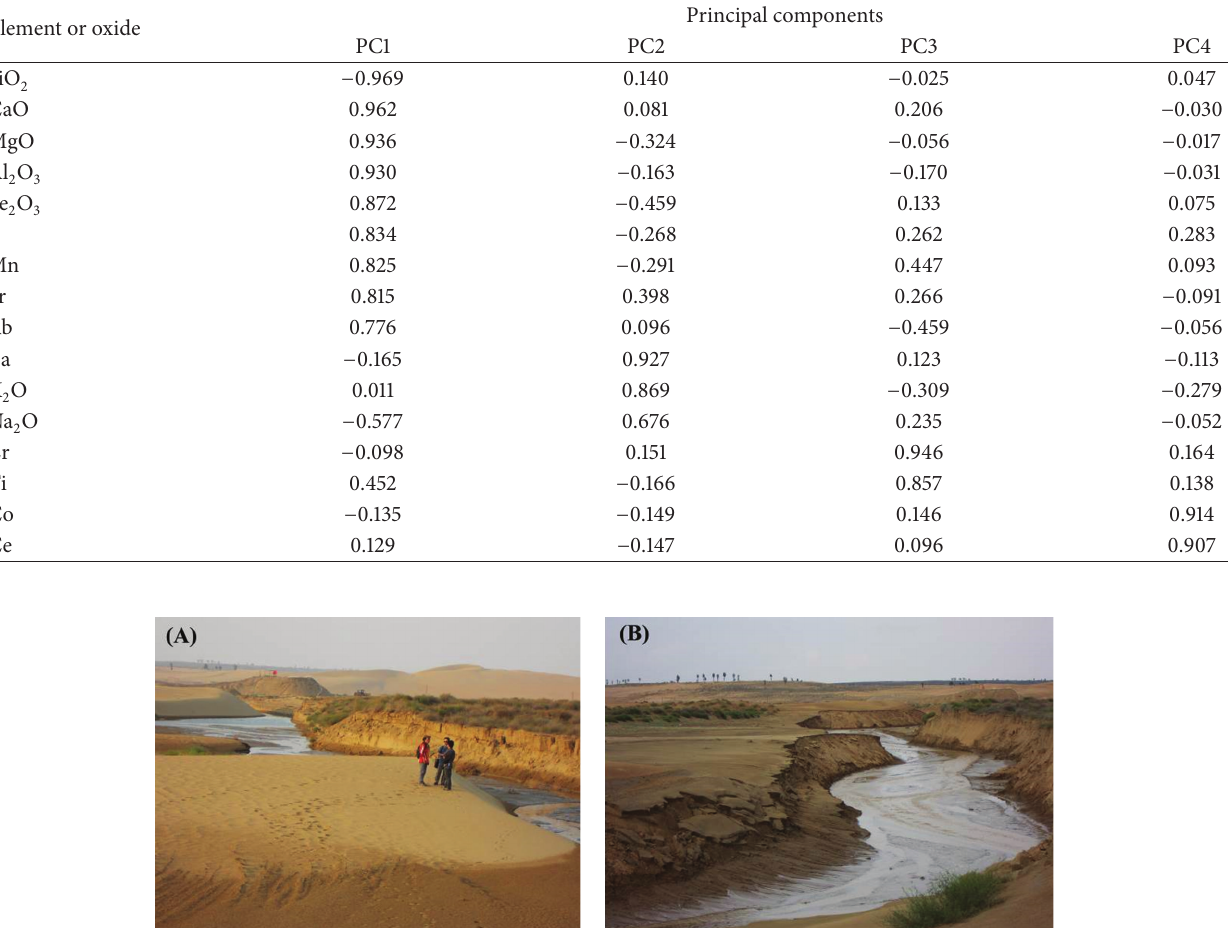
Table 4: Principal components analysis for the 16 major elements in suspended sediments ( 𝑛 = 75 ). The table shows principal components (PCs) with eigenvalues > 1.